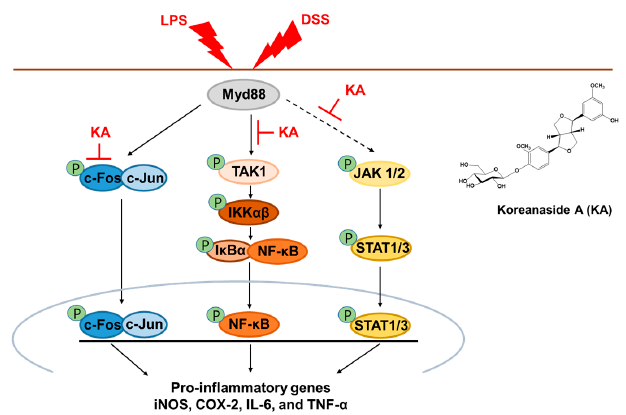
Figure 9. Proposal of molecular mechanism for anti-inflammatory and anti-colitic effects of KA.